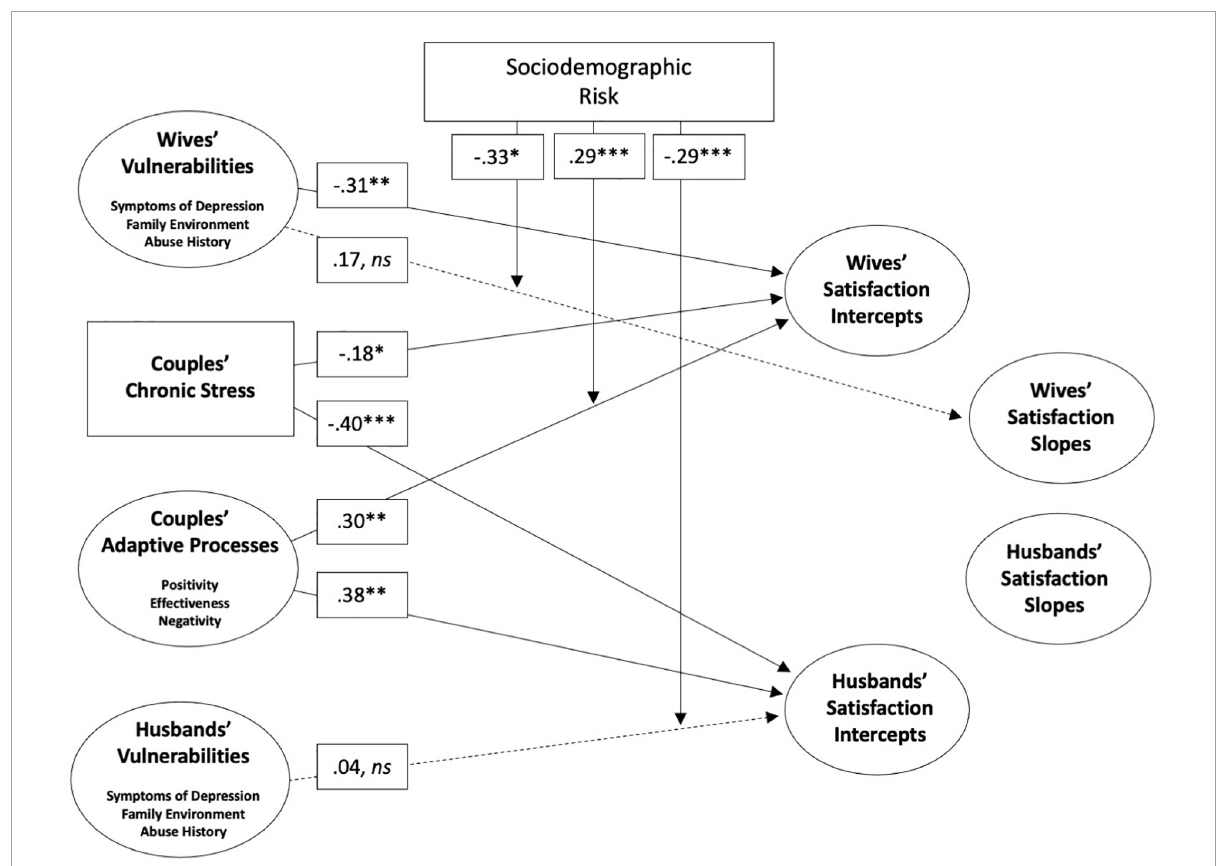
FIGURE2 Structural equation model showing moderating effects of sociodemographic risk on associations relating vulnerability, stress, and adaptive processes to husbands’ and wives’ satisfaction intercepts and slopes. Significant paths are shown. Dashed paths indicate non-significant main effects that were moderated by sociodemographic risk. N = 388 couples. ∗ p < 0.05, ∗∗ p < 0.01, ∗∗∗ p <